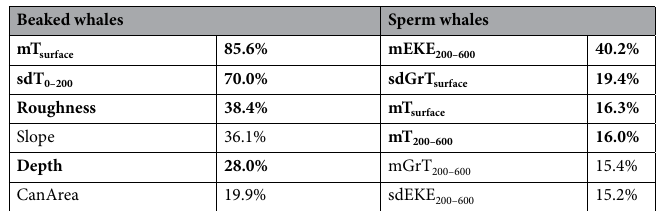
Table 1. Importance of variables ranked by the sum of the Akaike weights of the models in which they were selected. The higher the Akaike weight, the more important is the variable. The variables in bold are the variables selected in the final models used to predict the species distributions. T temperature; GrT gradients of temperature; EKE eddy kinetic energy; m mean; sd standard